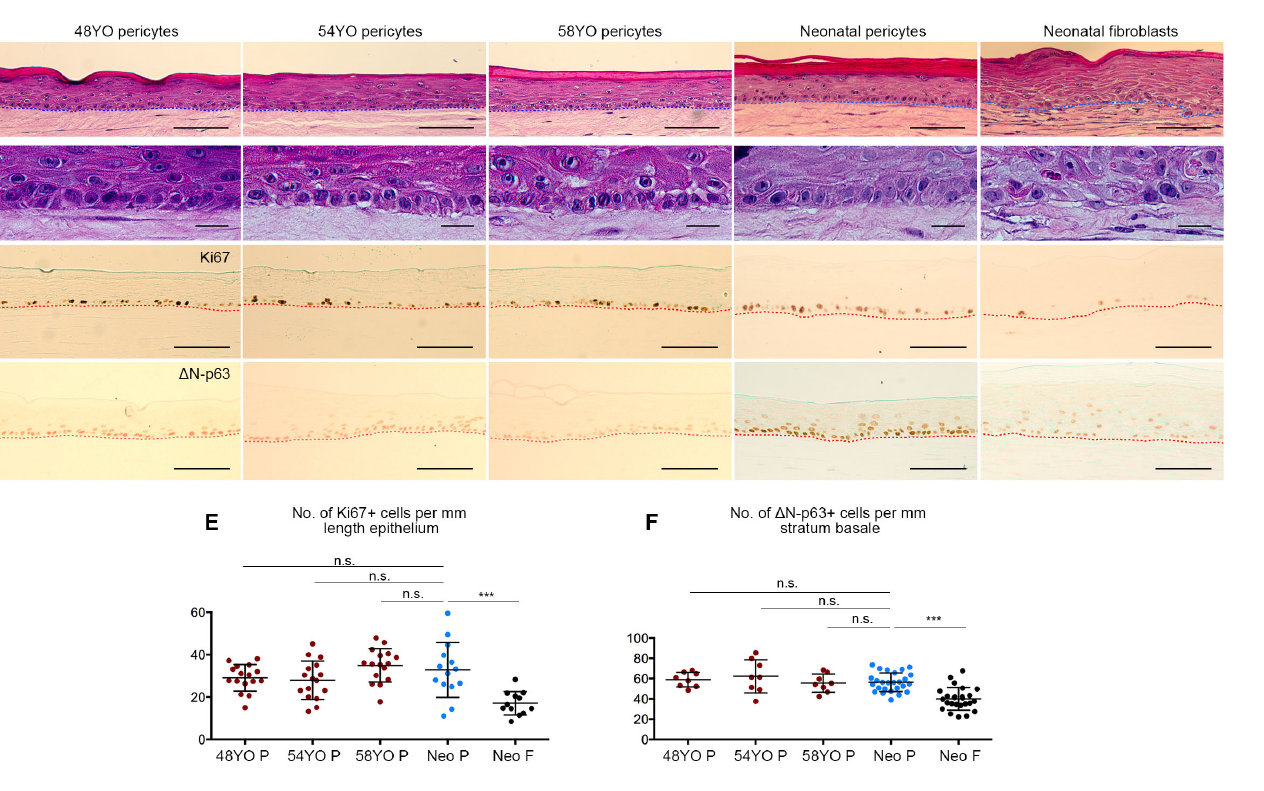
Figure 3. Some features of epidermal regeneration can be restored by aged pericytes in OCs. ( A , B ) Histological sections stained with haematoxylin and eosin; and ( C , D ) immunohistochemical staining of 3D skin cultures seeded with dermal pericytes from donors aged ~50–60 yo demonstrating their ability to promote epithelial tissue regeneration to a similar extent as neonatal pericytes ( A ) with re-establishment of proliferative and polarised basal keratinocytes compared to neonatal fibroblasts ( B ). Comparable Ki67 staining of basal keratinocytes was obtained with aged and neonatal pericytes but not fibroblasts ( C ); however, lower ∆ N-p63 + staining intensity was evident in organotypics seeded with aged pericytes ( D ). Scale Bar: 100 µ m. ( E , F ). Quantitation of Ki67 ( E ) and ∆ N-p63 ( F ) immunostaining confirming no statistically significant differences (n.s.) in the numbers of Ki67 + and ∆ N-p63 + basal cells obtained with neonatal versus aged pericytes, whereas their incidence was lower in fibroblast-seeded 3D cultures (*** = p < 0.001). Error bars represent mean ± SD. Data collected from 14–16 random fields from 2 ( E ) or 3 ( F ) independent